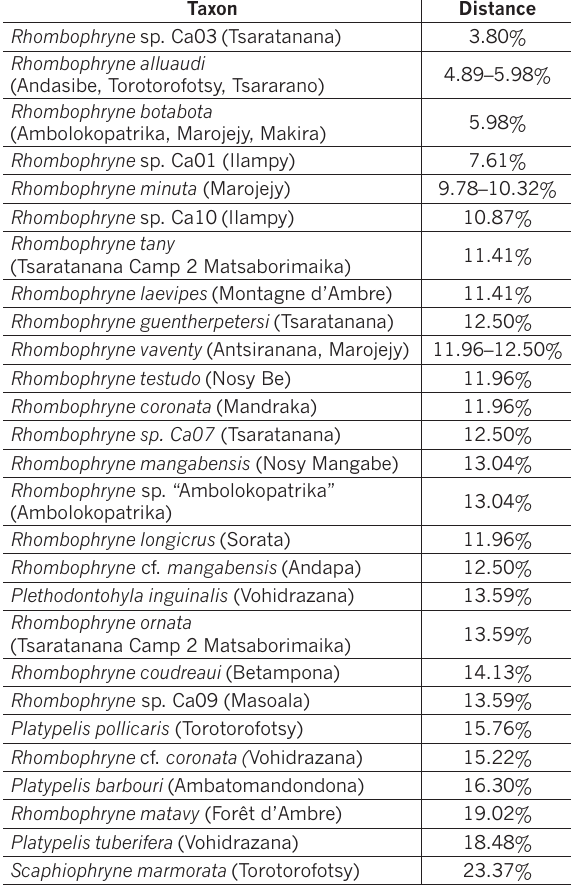
Table 2. Raw genetic distances at the 16s rRNA gene frag- ment between analysed taxa and Rhombophryne nilevina sp.